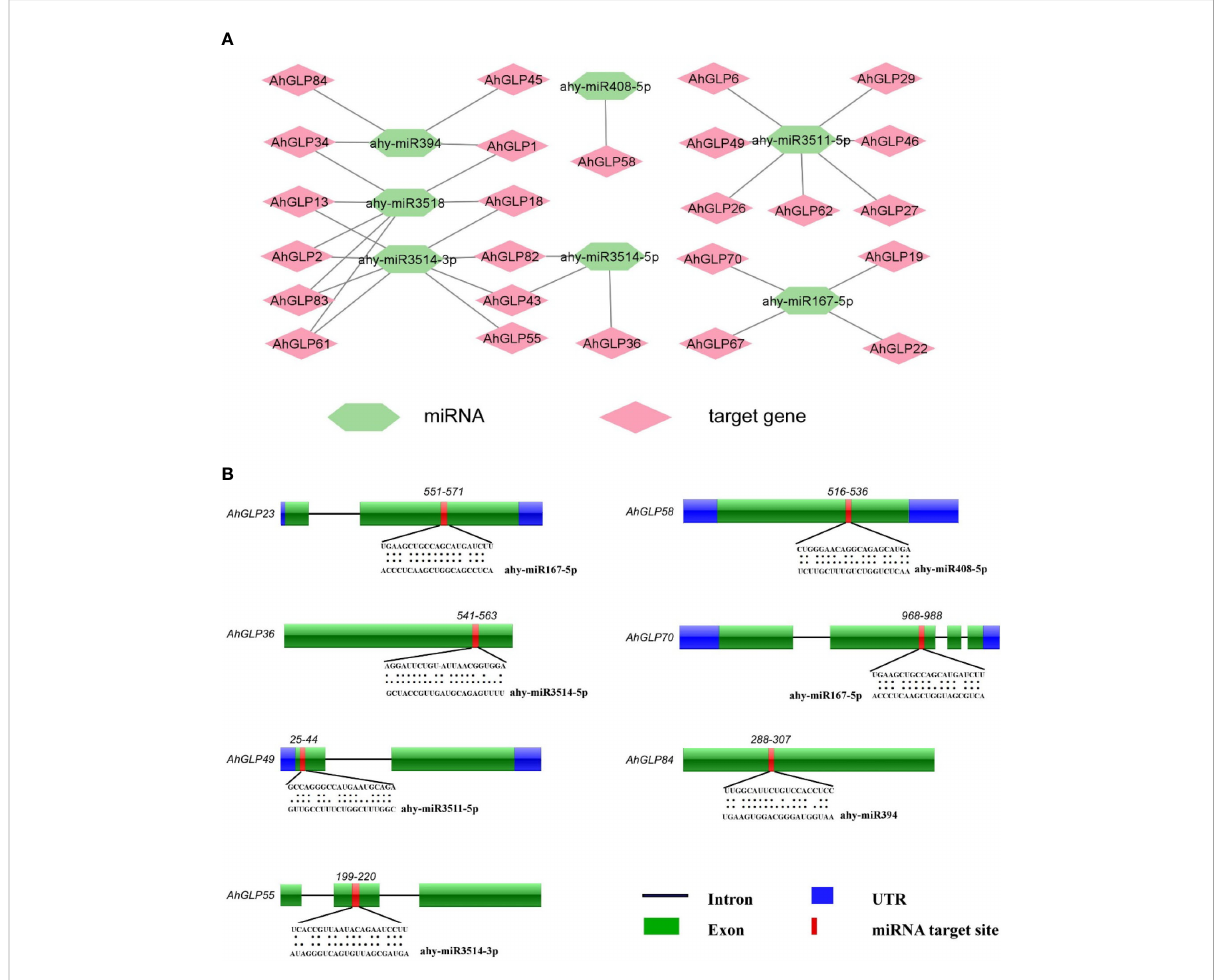
FIGURE 8 Predicted miRNAs targeting AhGLPs . (A) In total, 7 miRNAs were predicted targeting 25 Arachis hypogea Germin-like protein gens. (B) Schematic diagram of miRNAs target sites in some AhGLPs